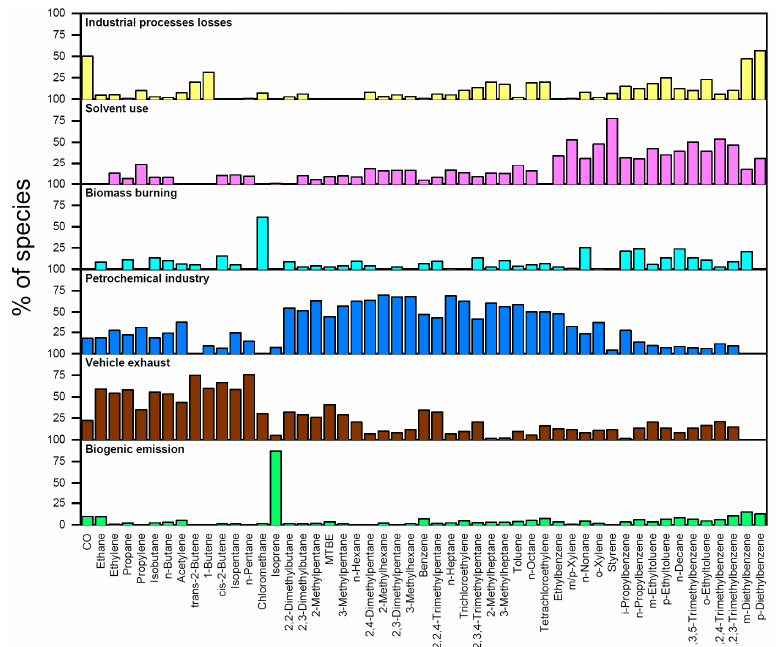
Figure 8. Source profiles derived from the positive matrix factorization (PMF) model at the MDS site.